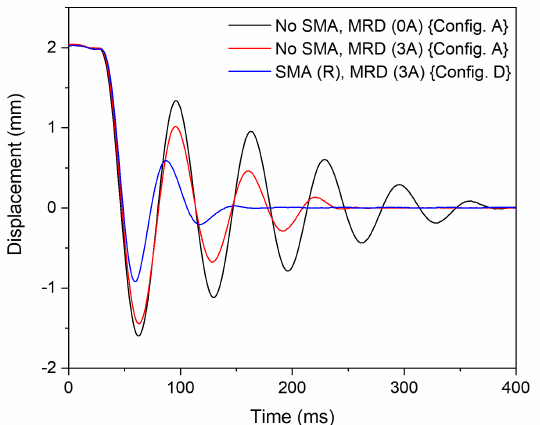
Figure 16. The displacement behaviour with respect to time showing the effect of hybrid SMA–MR damper (‘Config. D’) and MR damper (‘Config. A’) at a loading amplitude of 2